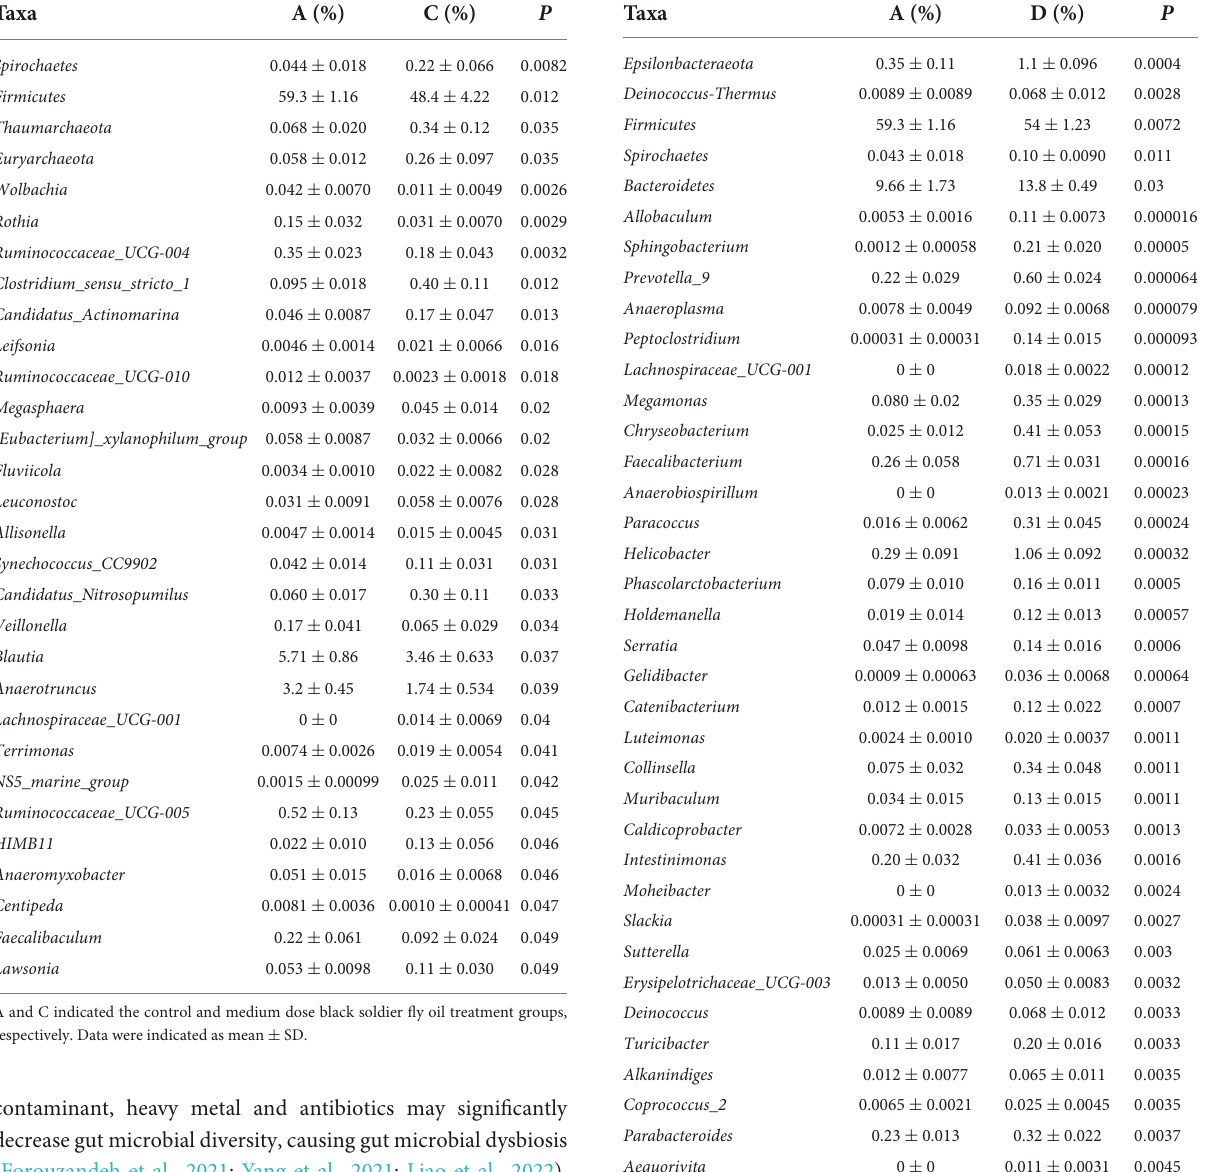
TABLE 4 Comparative analysis of differential bacteria between A and D